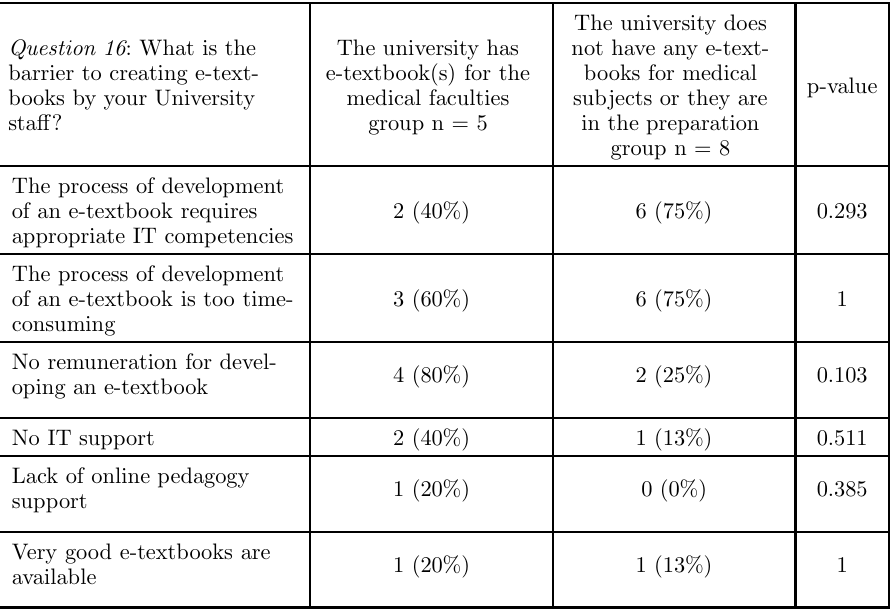
Table 1. Assessment of barriers to creating e-textbooks by university staff